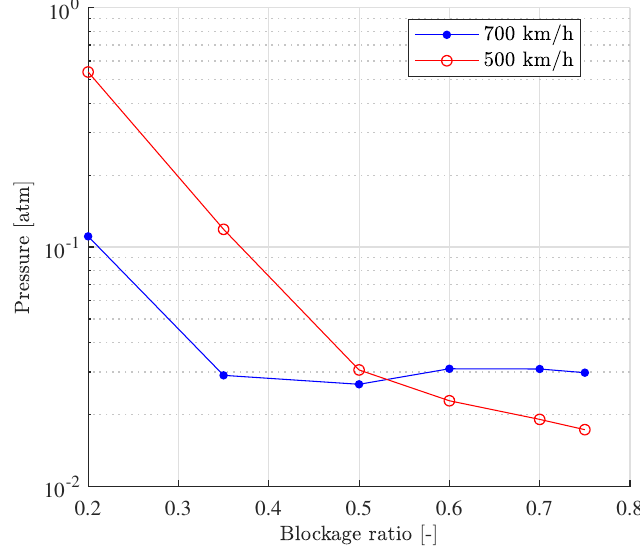
Figure 16. Equivalent pressure level for the base case that requires the same power as the compressor case at 0.1 atm for the different blockage ratios and